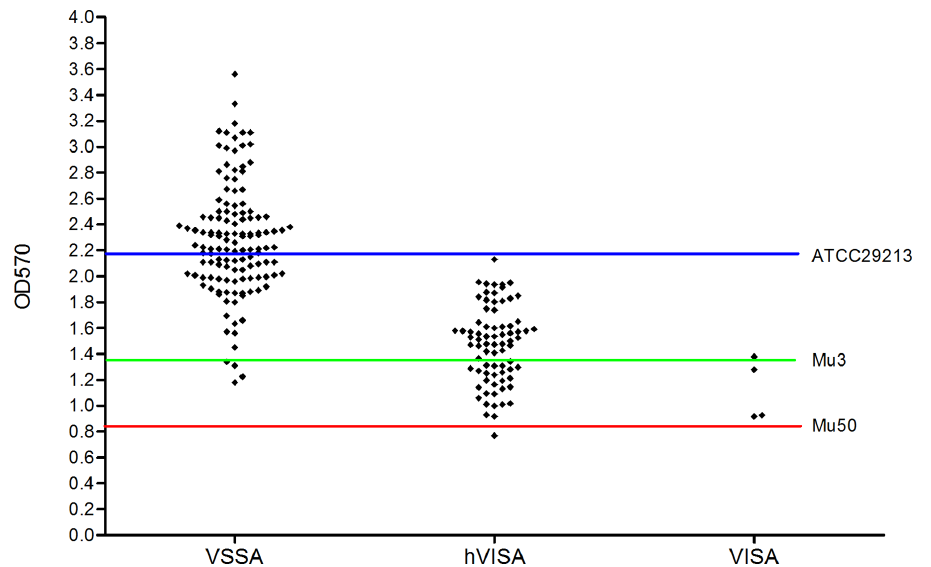
Figure 1. Quantification of biofilm formation was determined by crystal violet staining and read as an OD value. Each rhombus represents the mean OD value of one strain from five independent experiments. The ODs of most VSSA isolates (77/129, 59.7%) scattered above that of ATCC 29213 (the blue line; OD 570 =2.180), and the ODs of the majority of hVISA isolates (48/76, 63.2%) scattered between those of ATCC29213 and Mu3 (the green line; OD 570 =1.350). On the other hand, the ODs of the four VISA isolates scattered between those of Mu3 and Mu50 (the red line;